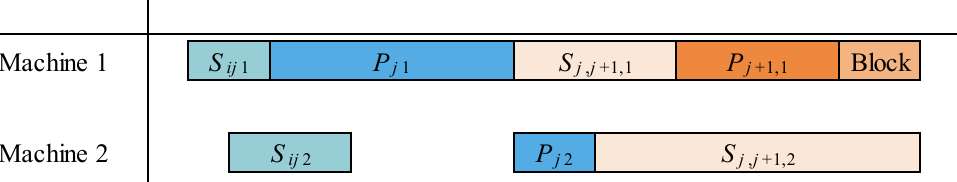
Fig. 1. Example of a blocking flow shop scheduling problem with setup